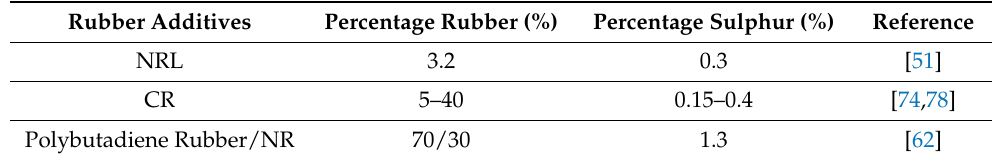
Table 15. Application of sulphur in rubber